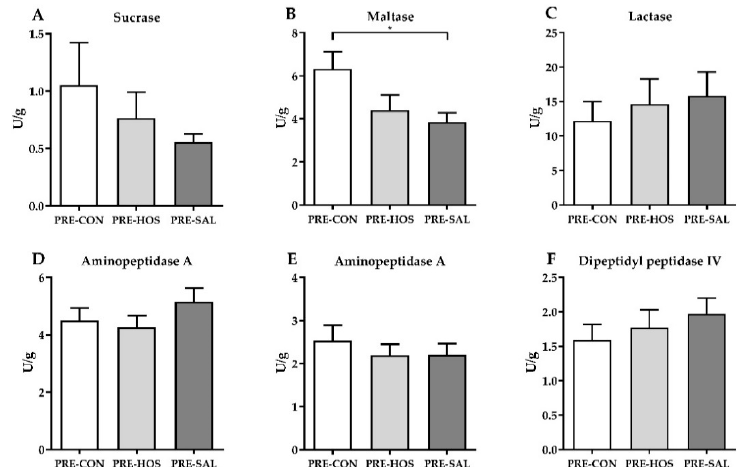
Figure 2. Small intestinal brush border enzyme activities in preterm pigs (Experiment 1). ( A ) Sucrase, ( B ) maltase, ( C ) lactase, ( D ) aminopeptidase N, ( E ) aminopeptidase A and ( F ) dipeptidyl peptidase IV. All were measured in the middle part of the small intestine. Values are presented as mean ± SEM. The * indicate statistical significant difference between groups of p < 0.05.